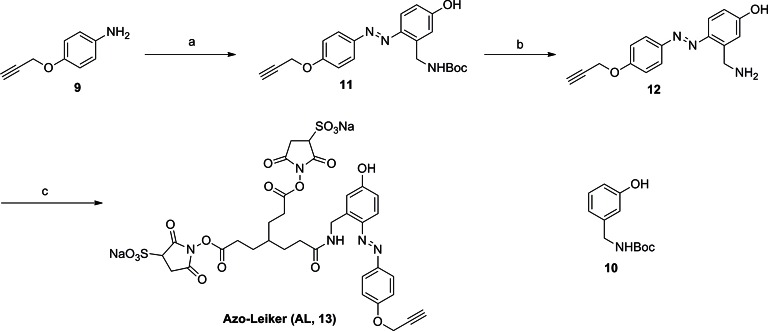
Synthesis of Azo-Leiker (AL, 13).